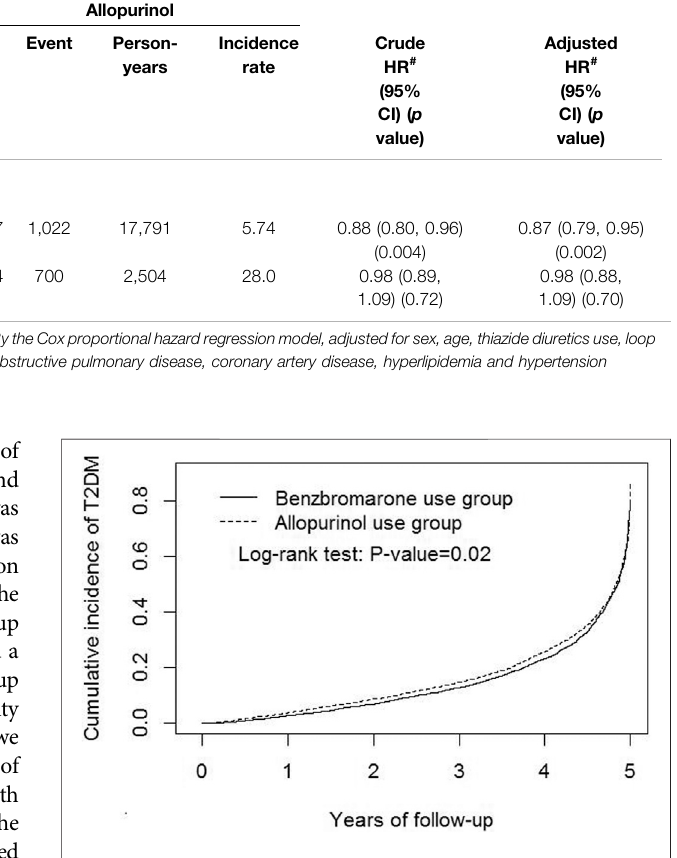
FIGURE 2 | Kaplan-Meier model demonstrated that the cumulative incidence of type 2 diabetes mellitus was lower in benzbromarone users than that in allopurinol users at the end of the follow-up period ( p (cid:1)